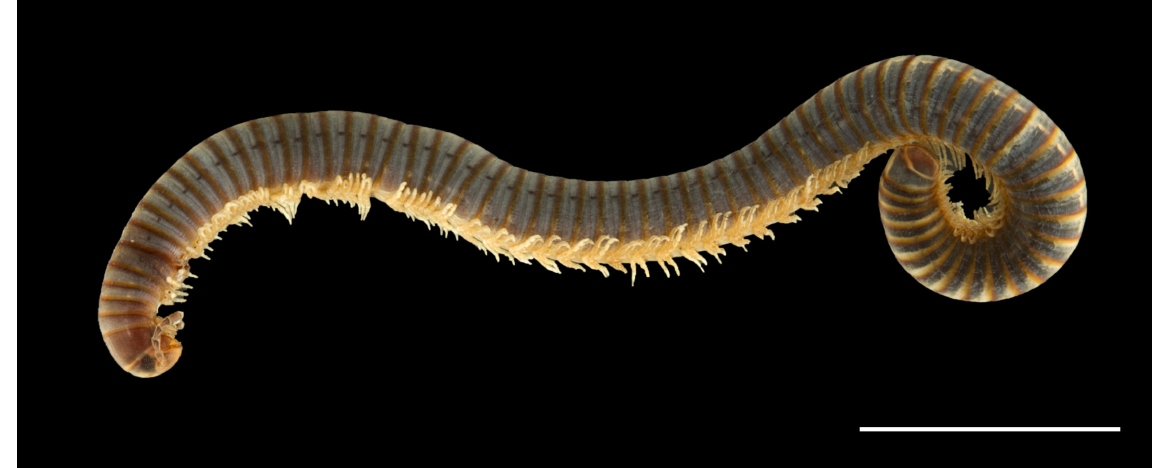
Fig. 1. Calyptomastix ingemanni sp. nov., paratype (NHMD 621716), to show typical odontopygid habitus. Scale bar = 1 cm. Photo S.G.